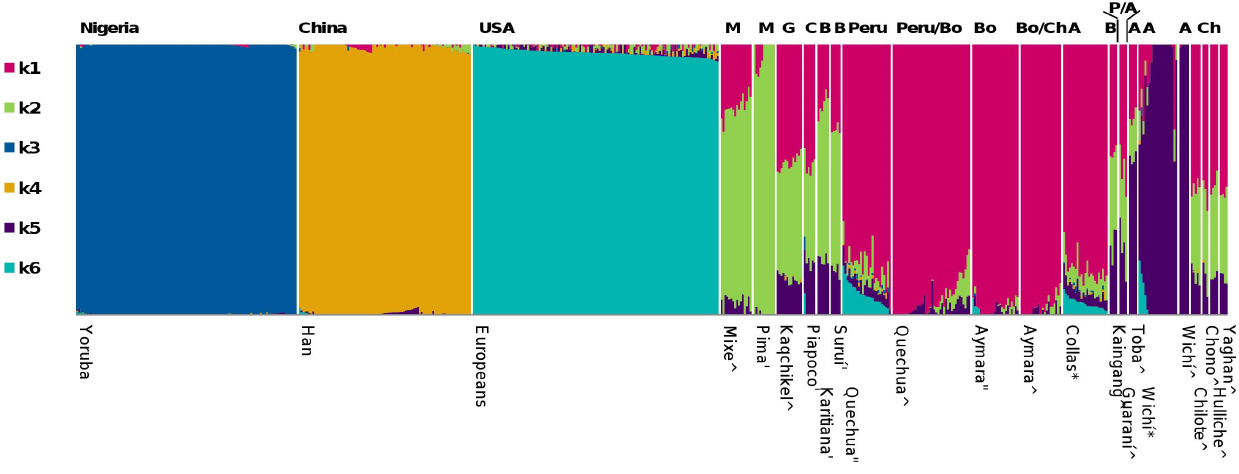
Figure 1. ADMIXTURE components of Argentinean Natives in a worldwide context. Populations are divided by six admixture proportions as K=6 indicated the best fit for the data. The main proportions are derived from Yoruba (k3), Han Chinese (k4), Europeans (k6), Mexicans (Mixe/Pima, k2), Andean populations (k1) and Wichı´ (k5). Collas are indistinguishable from Aymara and Quechua, while Chilean Andeans mainly consist of Andean (k1) and Mixe/Pima (k2) characteristic admixture proportions. Gran Chaco populations (Kaingang, Chane´, Guaranı´ and Toba) carry Wichı´